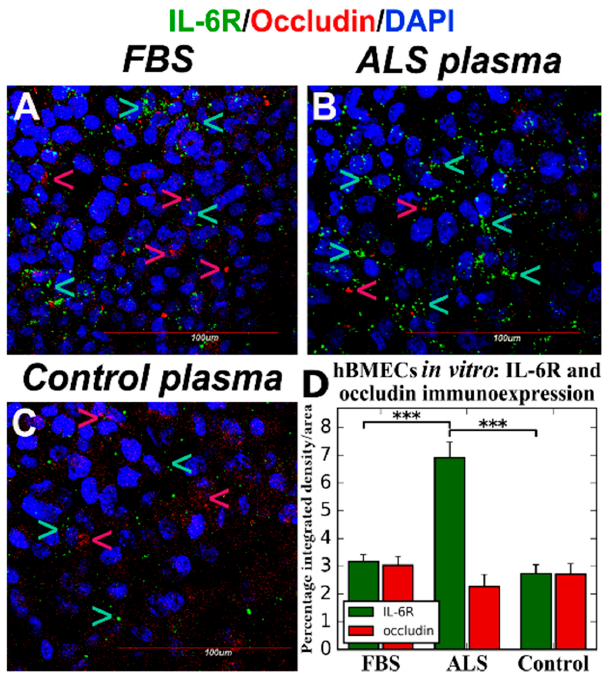
Figure 1. Confocal fluorescent images of hBMECs immunostained for IL-6R and occludin in vitro. Double immunostaining for IL-6R and occludin was performed on fixed hBMECs after 5 DIVexposure to FBS, plasma from ALS or control patient. The cells containing ALS plasma in media demonstrated significantly increased IL-6R (green, arrow) and reduced occludin (red, arrow) immunoexpressions ( B , D ). There were no differences in IL-6R or occludin immunoexpression between culture cells after exposure to FBS ( A ) or plasma from control subject ( C ). DAPI (blue) was used for nuclei staining. Data are presented as means ± S.E.M. Scale bar in A – C is 100 µm. *** p < 0.001. Additionally, cytokine profile (IL-1 β , IFN- γ , IL-2, IL-4, IL-5, IL-6, IL-8, IL-10, and TNF- α ) using multiplex cytokine assay (Thermo Fisher Scientific, Waltham, MA, USA) as described [30] was performed in collected media supernatant from insert (luminal) and 24-well plate (abluminal) compartments prior to hBMEC fixation after 5 DIV of exposure to 10% FBS, plasma from ALS or control patient. Our preliminary data showed significantly elevated concentrations of IFN- γ ( p < 0.05), TNF- α ( p < 0.001), IL-5 ( p < 0.01), and IL-6 ( p < 0.05) cytokines at luminal (insert) compartment primarily after cell exposure to ALS plasma (Figure 2). However, significant difference in IFN- γ and IL-6 concentrations was shown only between ALS plasma and FBS exposures. Interestingly, no differences ( p > 0.05) in cytokine levels were found between any cell culture conditions at abluminal (24-well plate) side.